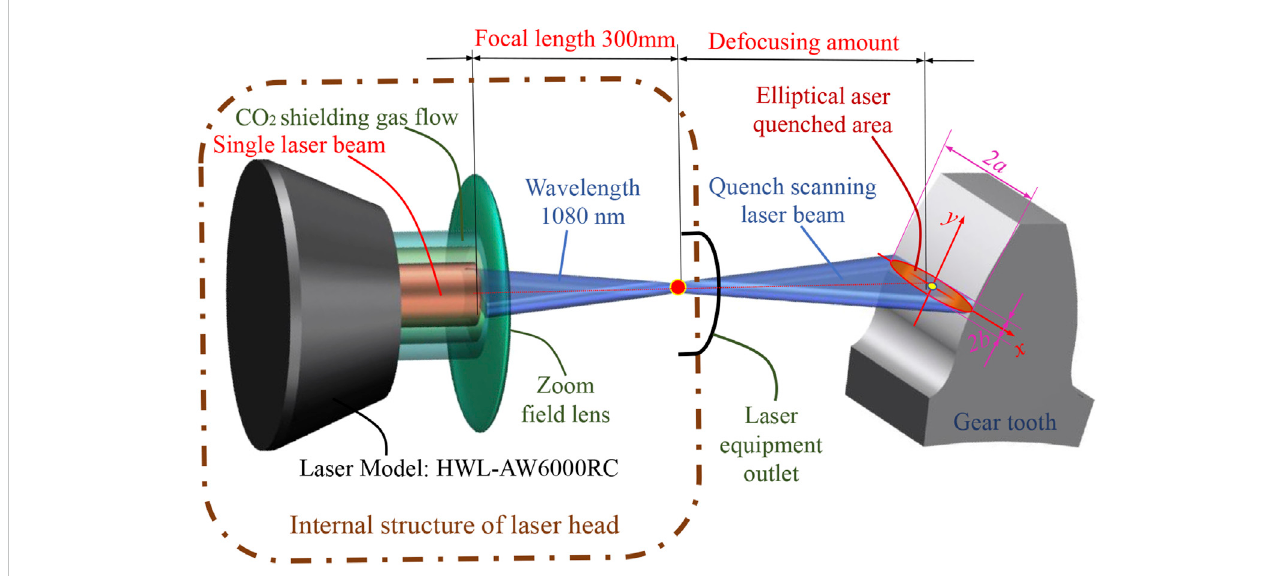
FIGURE 1 Variable depth quenching principle of gears by laser